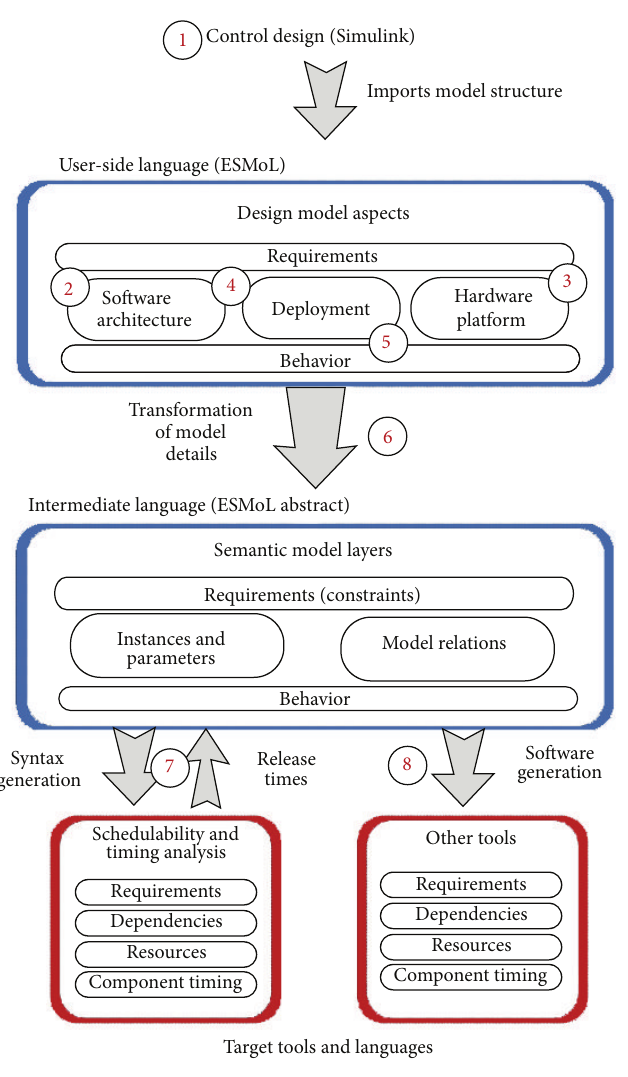
Figure 2: Automotive embedded control software design flow supported by the ESMoL language and modeling